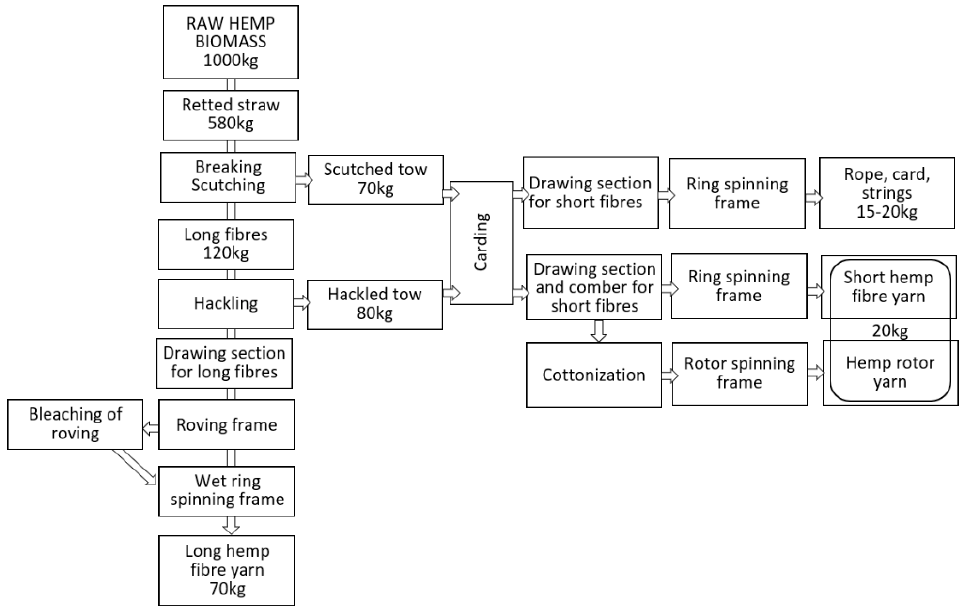
Figure 19. Flow chart of traditional flax/hemp spinning system ( own elaboration ).